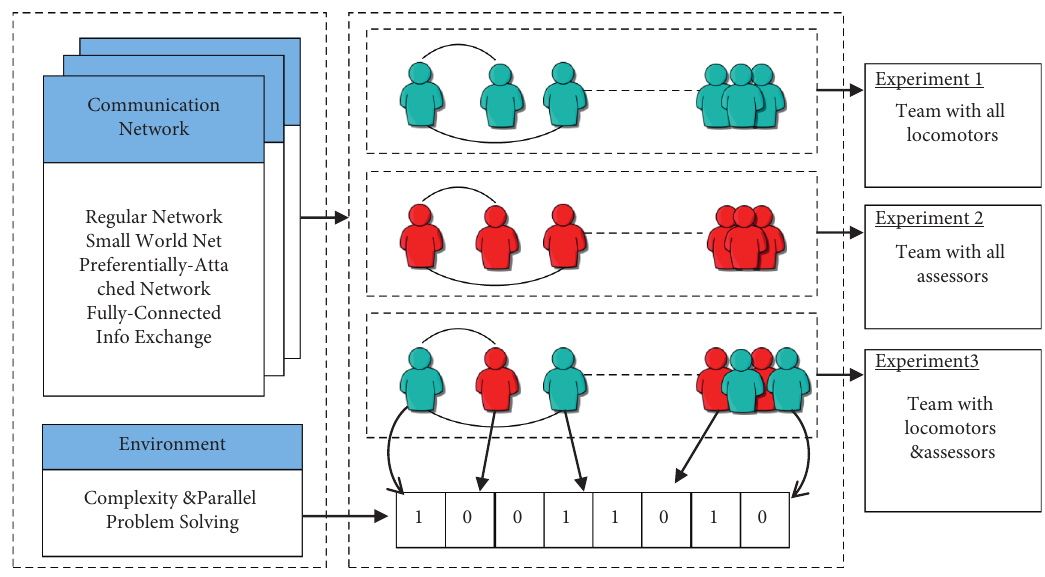
Figure 1: Simulation experiment